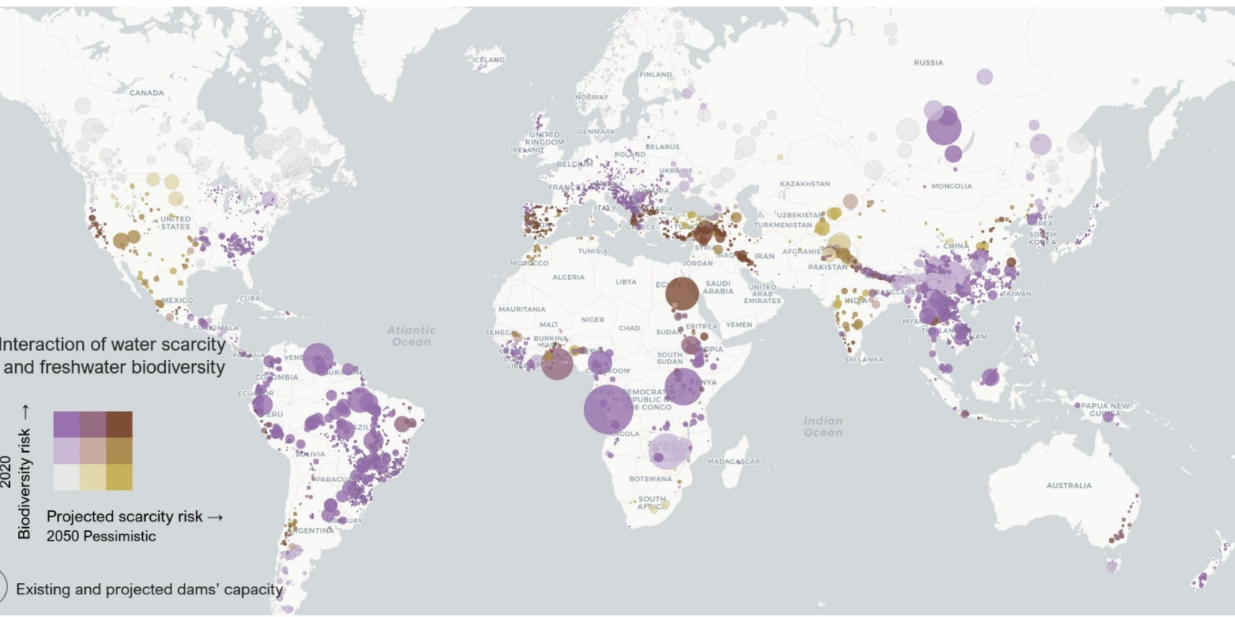
Figure 16. All hydropower dams in this study (existing and projected) with color indicating combined risks of biodiversity loss and future water scarcity, using the same color pattern as Figure 15. The size of circles indicates the hydropower capacity of the dam. See the interactive version of this map at https://rcamargo.shinyapps.io/HydropowerClimateChange; (accessed 21 January